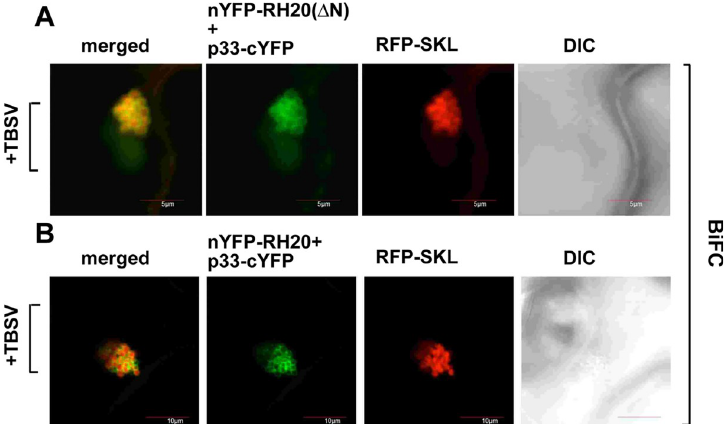
Fig 7. Interaction between RH20 Δ N helicase and the TBSV replication protein in plants. (A-B) Interactions between TBSV p33 replication protein and the RH20 Δ N helicase (panel A) or the full-length RH20 (panel B) were detected by BiFC. The TBSV p33-cYFP replication protein and the nYFP-RH20 Δ N , nYFP-RH20 and the RFP-SKL peroxisomal marker protein were expressed via agroinfiltration in N . benthamiana . The merged image shows the efficient co-localization of the peroxisomal RFP-SKL with the BiFC signals, indicating that the interactions between the tombusvirus p33 replication protein and the recruited RH20 Δ N and RH20 helicases occur in the large VROs, which consist of aggregated peroxisomes. Scale bars represent 10 μ m.